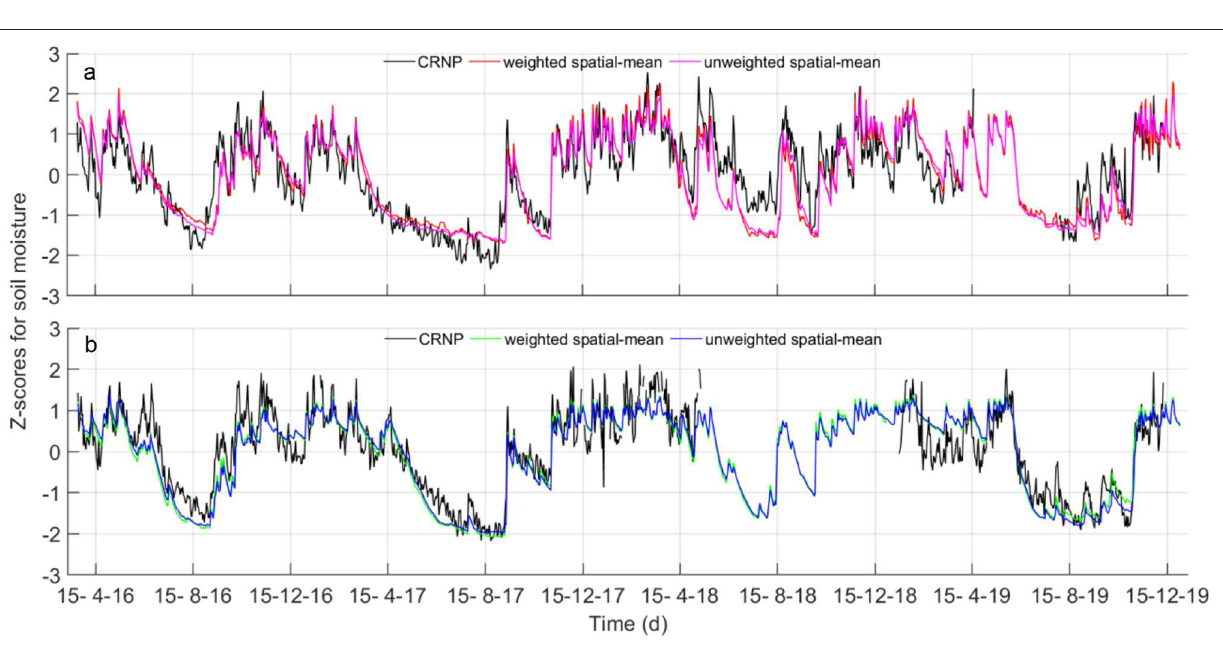
mismatch between the areal θ and the point-scale ψ